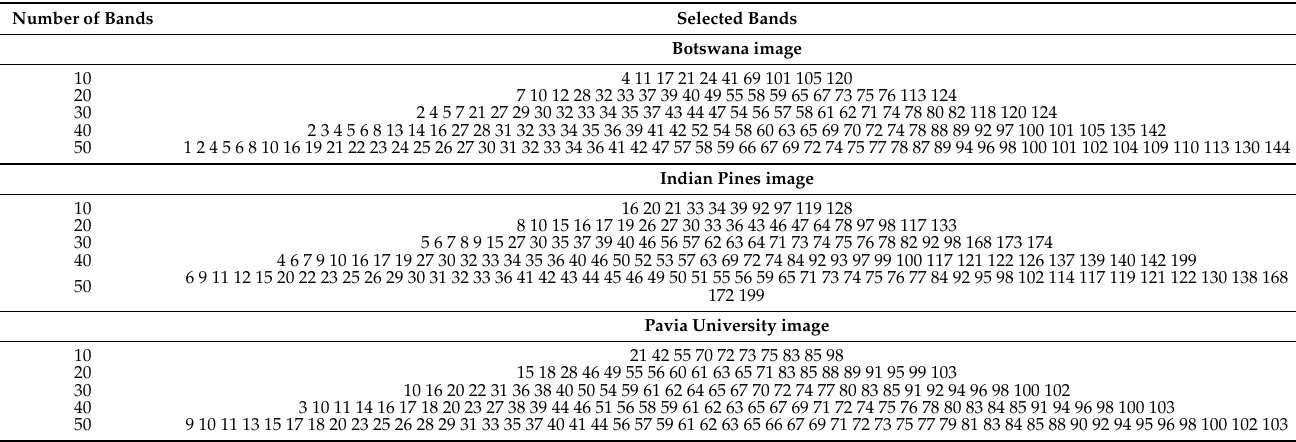
Table 5. All the bands selected by the proposed CW method.